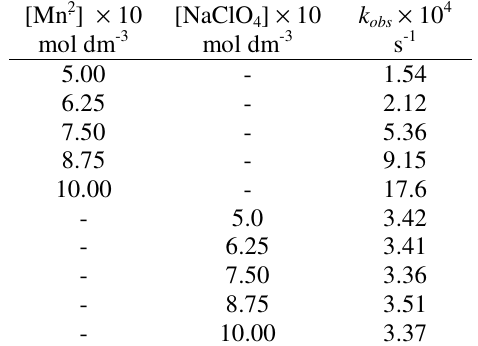
Table 3. Effect of manganous sulphate and sodium perchlorate.